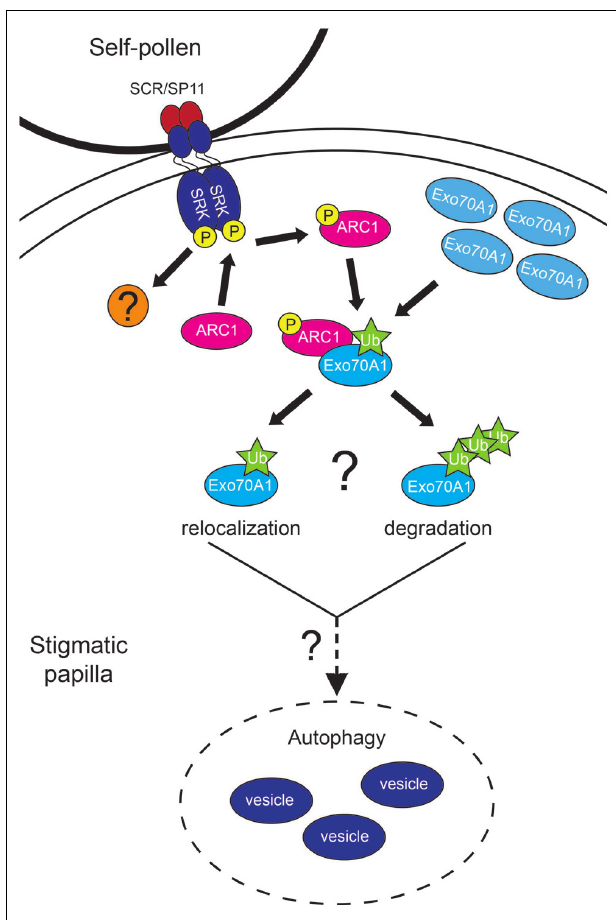
FIGURE 1 | Model for the Self-Incompatibility response in Arabidopsis. Upon pollen contact with the stigmatic papilla, the papilla must determine if the pollen grain is self or non-self. For a self-pollen grain, the SCR/SP11 ligand binds to SRK, and SRK will then become phosphorylated. ARC1 interacts with the phosphorylated cytoplasmic kinase domain of SRK and become phosphorylated and activated. ARC1 then seeks its target for ubiquitination, Exo70A1, which is located at the plasma membrane in preparation for exocyst-mediated exocytosis. ARC1, with the help of an E1 activating enzyme and E2 conjugating enzyme, ubiquitinates Exo70A1.The nature of this ubiquitination is not known, as it could be either mono-ubiqitination resulting in Exo70A1 relocalization, or poly ubiquitination leading to degradation of Exo70A1 by the 26S proteosome. Either way, the inhibition of Exo70A1 appears to activate an autophagic response that leads to degradation of the secretory vesicles.There is also another (unknown) factor functioning downstream of SRK in this pathway. How ARC1, this factor, and the ubiquitination of Exo70A1 signals for autophagy is not known. Once the secretory vesicles have been removed, the self-pollen grain will not receive the resources needed for hydration and germination; as a result will be